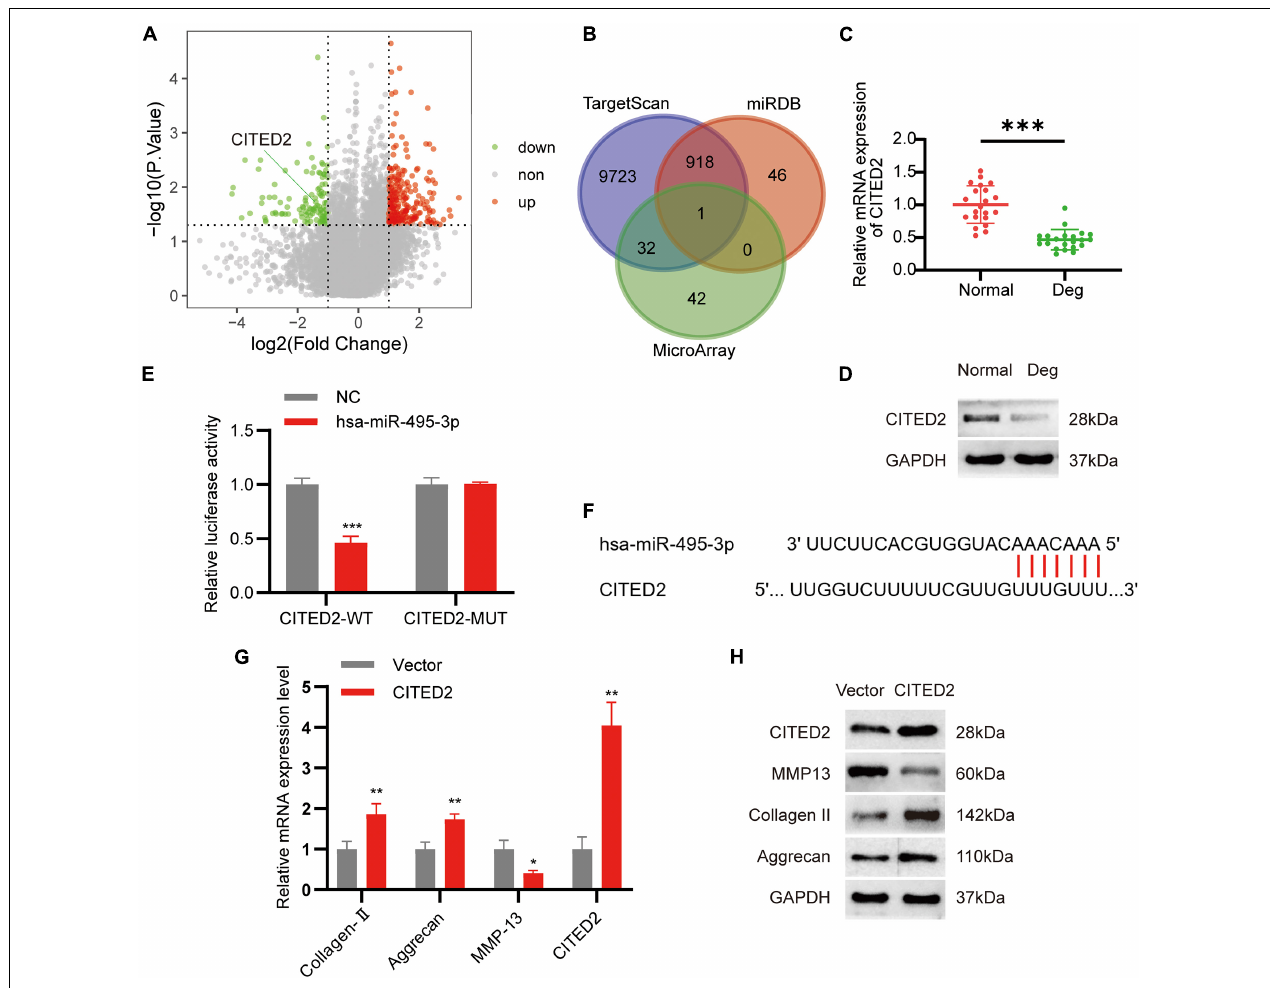
FIGURE 5 | MiR-495-3p targets the CITED2 and CITED2 promotes cell proliferation inhibit ECM degeneration. (A) Volcano plot of the significantly upregulated and downregulated mRNAs. (B) Venn diagram demonstrating the intersection of downregulated mRNAs and predicted target mRNAs. (C,D) The expression levels of CITED2 in CEP tissues were measured in 21 patients and 21 controls by qRT-PCR and Western blot (*** P < 0.001). (E) Luciferase reporter analysis of either wild-type or mutant CITED2 3 (cid:48) -UTR activity. miR-495-3p was co-transfected with the wild-type or mutant vector. The presented values are the mean ± SEM of three different preparations (*** P < 0.001). (F) 3 (cid:48) -UTR region of CITED2 mRNA was found to harbor a binding site for miR-495-3p. (G,H) The expression of CITED2, MMP13, Collagen II, and Aggrecan expression levels was assessed by qRT-PCR and Western blotting (* P < 0.05, ** P <